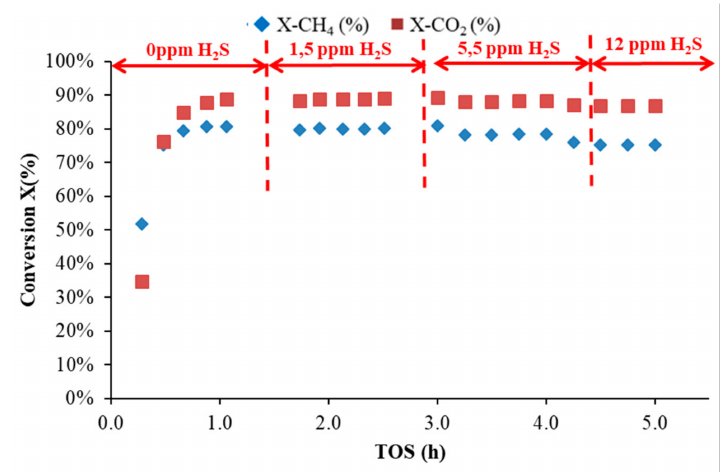
Figure 6. Catalytic performances of Ni-UGSO on DRM at low H 2 S loads (CO 2 /CH 4 = 0.96, 810 ◦ C).